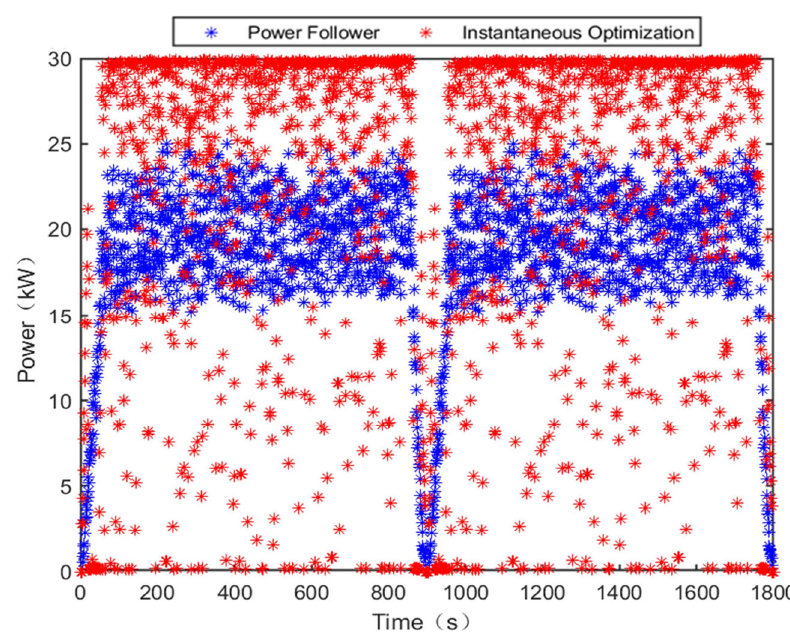
Figure 18. Working power of motor.